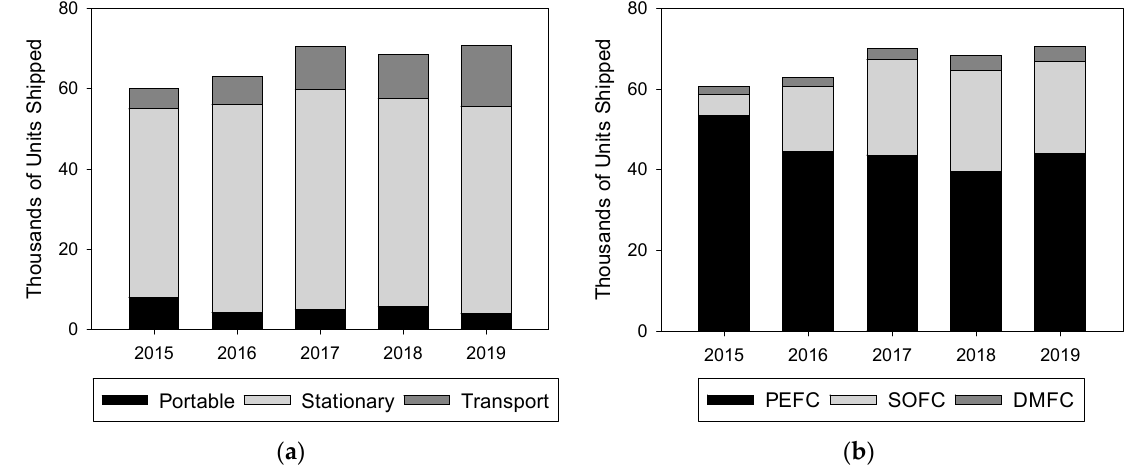
Figure 1. Fuel cell units shipped between 2015 and 2019 (2019 includes a partial forecast) by ( a ) application and ( b ) fuel cell type reproduced from [12].